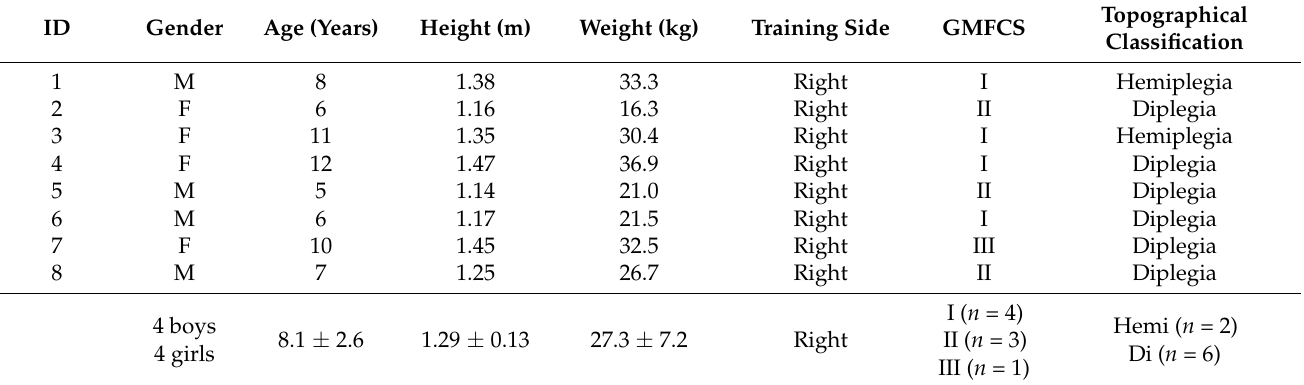
Table 1. Demographics and characteristics of the study participants who completed the training